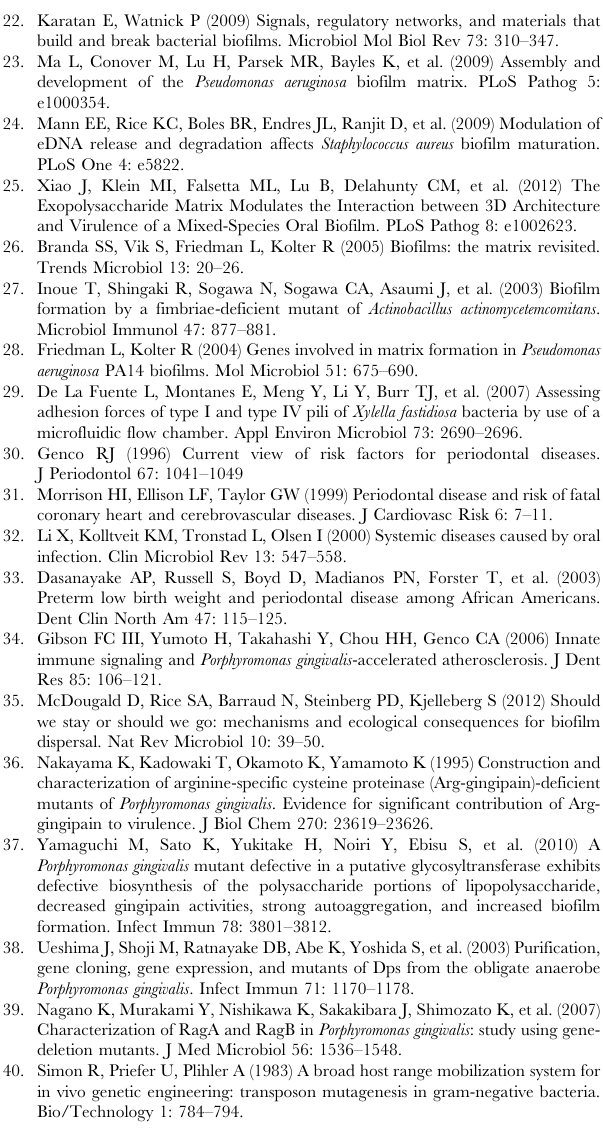
Figure S1 Quantification of mean thickness and aver- age substratum coverage from CLSM observation. Fluorescent images of CLSM (Figures 2A and 2B) were quantified using Imaris software and the mean thickness of cells (A) and